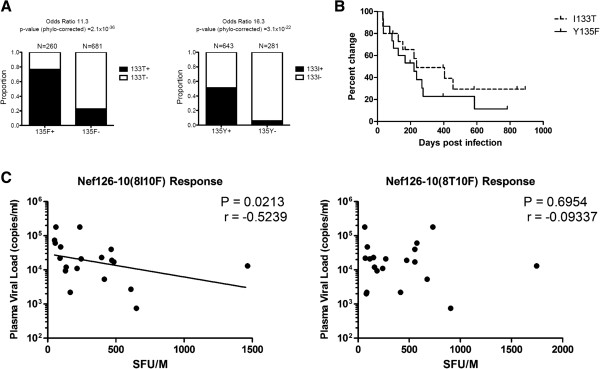
Relevance of I133T mutation to Y135F and its impact on CTL responses. (A) The cross-sectional analysis of the co-variation relationship between Nef codons 133 and 135. Nef codons containing gaps or amino acid mixtures were excluded from analysis, leaving 941 and 924 sequences for analysis of codon pairs 135F/133T and 135Y/133I, respectively. (B) Kaplan-Meier plot of the emergence of Y135F and I133T mutations in a multicenter longitudinal acute/early infection cohort comprising 16 HLA-A*24:02-expressing persons. (C) Within 24 patients who harboring 133I/135F or 133T/135F mutant, correlation between the magnitude of peptide-specific response and pVL was examined. Peptide-specific response was determined by using ex vivo IFN-γ ELISpot assay with frozen PBMCs. Each point is plotted according to the average SFU of duplicate wells and the measured pVL at the sampling point. Statistical significance of the correlation between the magnitude and pVL was calculated by Spearman’s rank correlation.